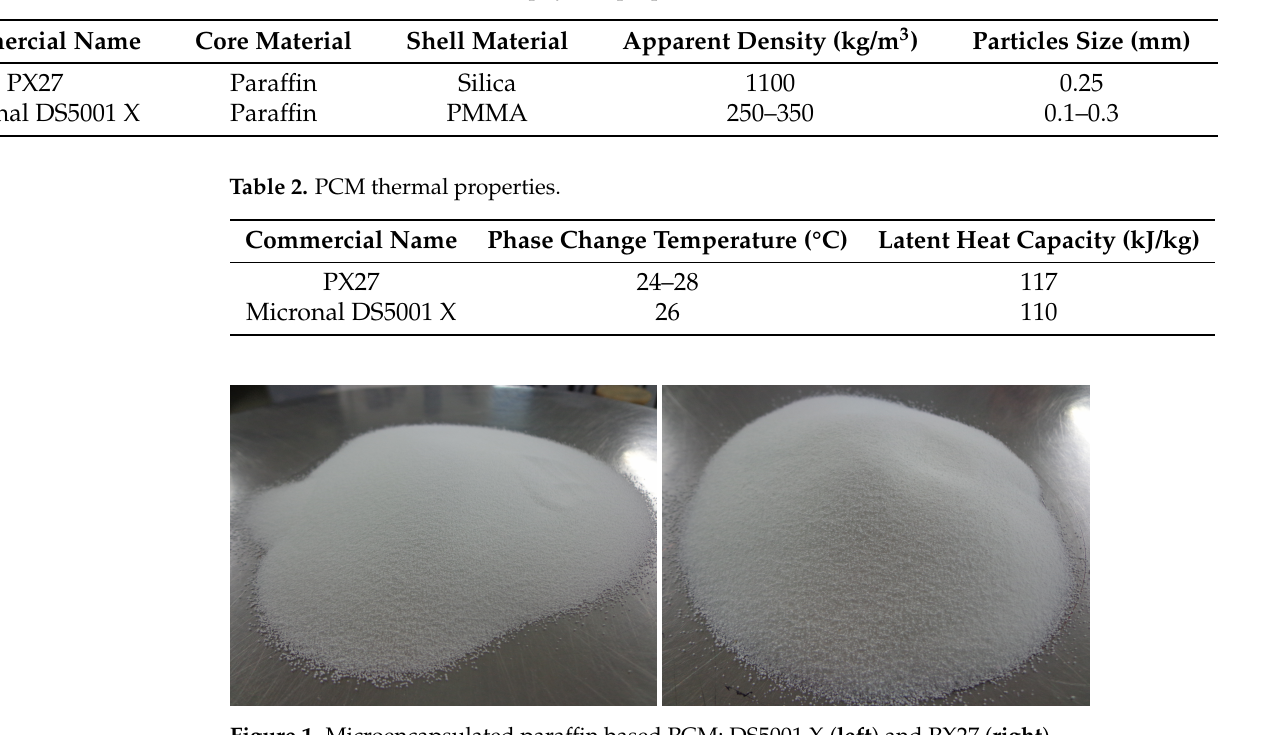
Table 1. PCM physical properties.